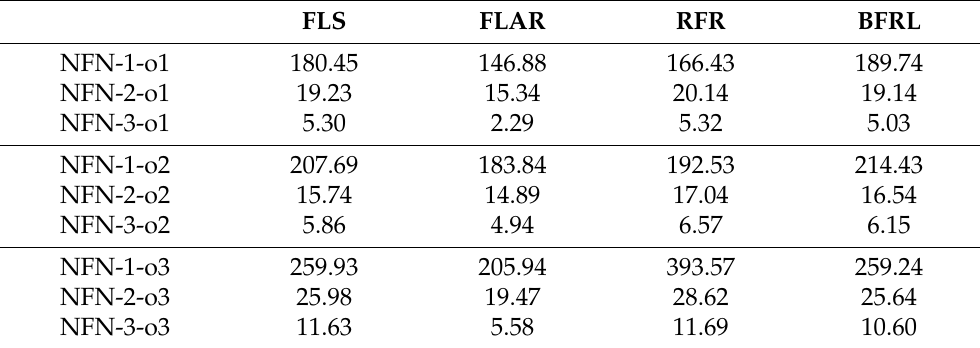
Table 4. Total errors of the fuzzy least squares (FLS), the fuzzy least absolute linear regression (FLAR), the robust fuzzy regression (RFR) analysis, and the Boscovich fuzzy regression line (BFRL) (first row) tested on datasets with non-symmetric fuzzy numbers, NFN-1, NFN-2, and NFN-3, affected by outliers of type o1, o2 and o3 (first